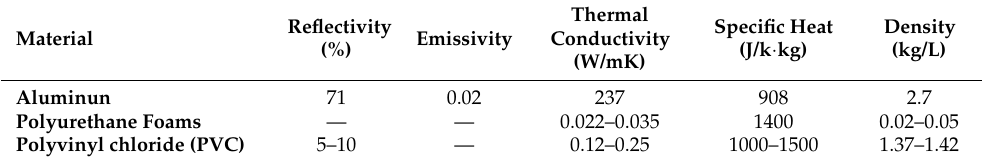
Table 1. Thermophysical properties of aluminum, polyvinyl chloride (PVC) and polyurethane foams.